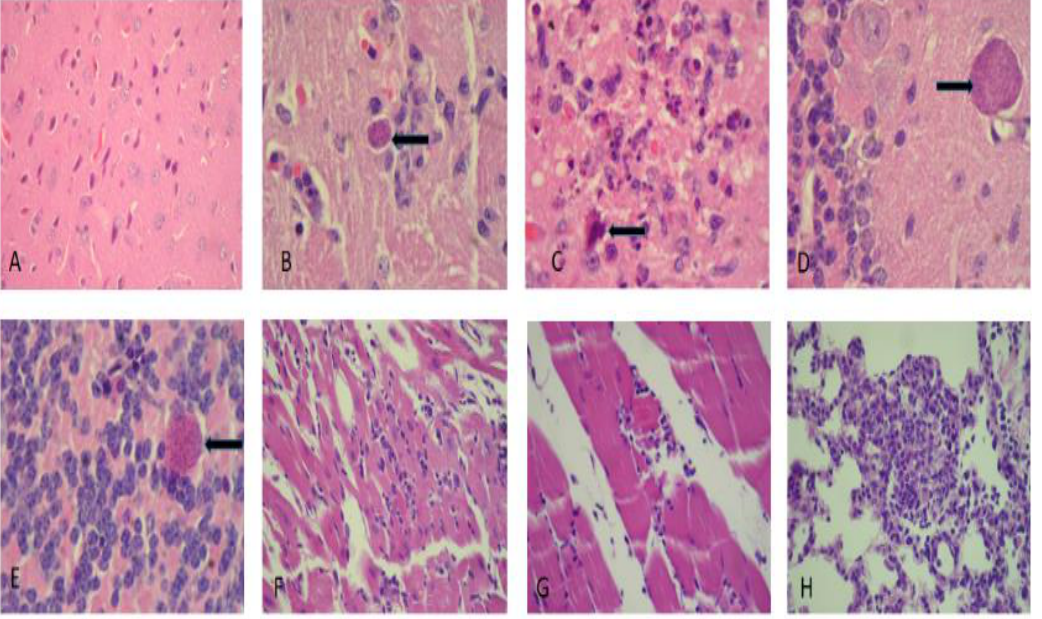
Figure 8. Histological cuts from brain, cardiac muscle and lung in the acute-infected group. ( A ) Brain cortex illustrating neuronal hypoxia (400 × ), ( B ) gliosis with a Toxoplasma gondii bradyzoite cyst (400 × ), ( C ) site exhibiting glionecrosis with a neuron in apoptosis (1000 × ), ( D , E ) Toxoplasma cyst placed in the cerebellar molecular and the granular layers (1000 × ), ( F ) moderate myocarditis (400 × ), and ( G ) moderate myositis with a fragmented muscle fiber (400 × ), ( H ) focal pneumonitis with acute and chronic components (400 × ). The arrows indicate Toxoplasma cysts except in figure C wich indicates an apoptotic cell.